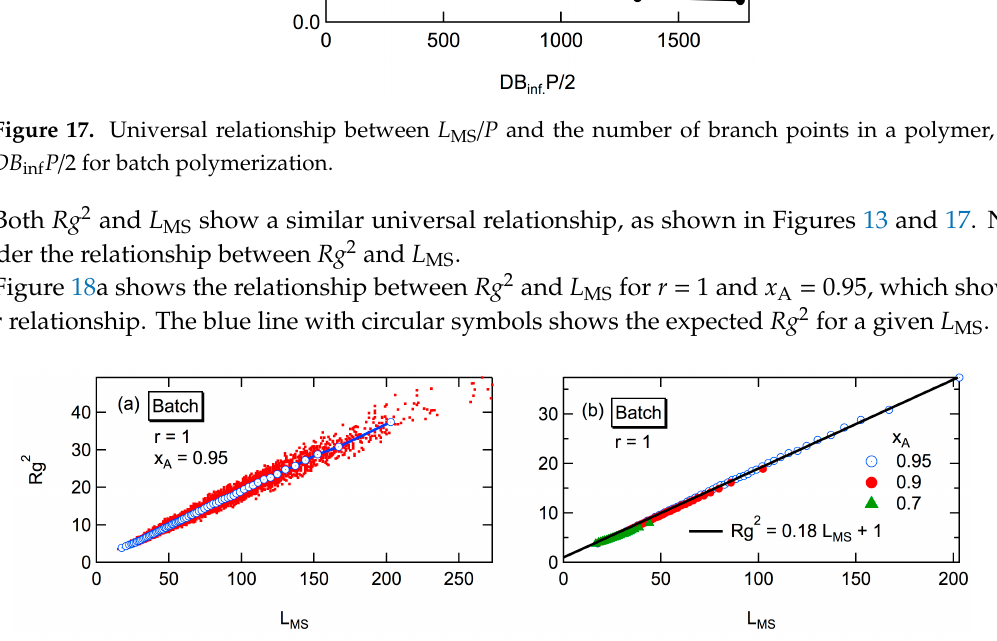
Figure 18. Relationship between Rg 2 and L MS for batch polymerization with r = 1. ( a ) Raw data (red dots) and the averages within ∆ L MS , i.e., the expected Rg 2 -values, at x A = 0.95. ( b ) Expected Rg 2 for a given L MS with various conversion levels.